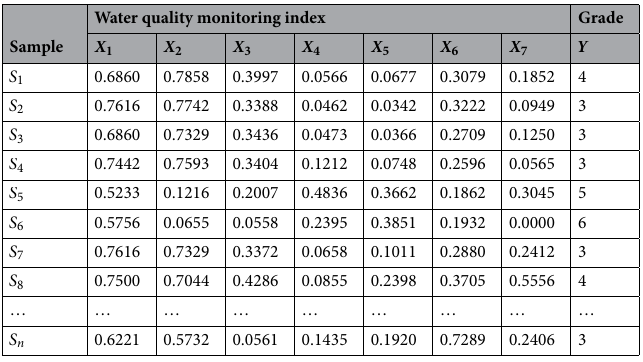
Table 8. Partial sample